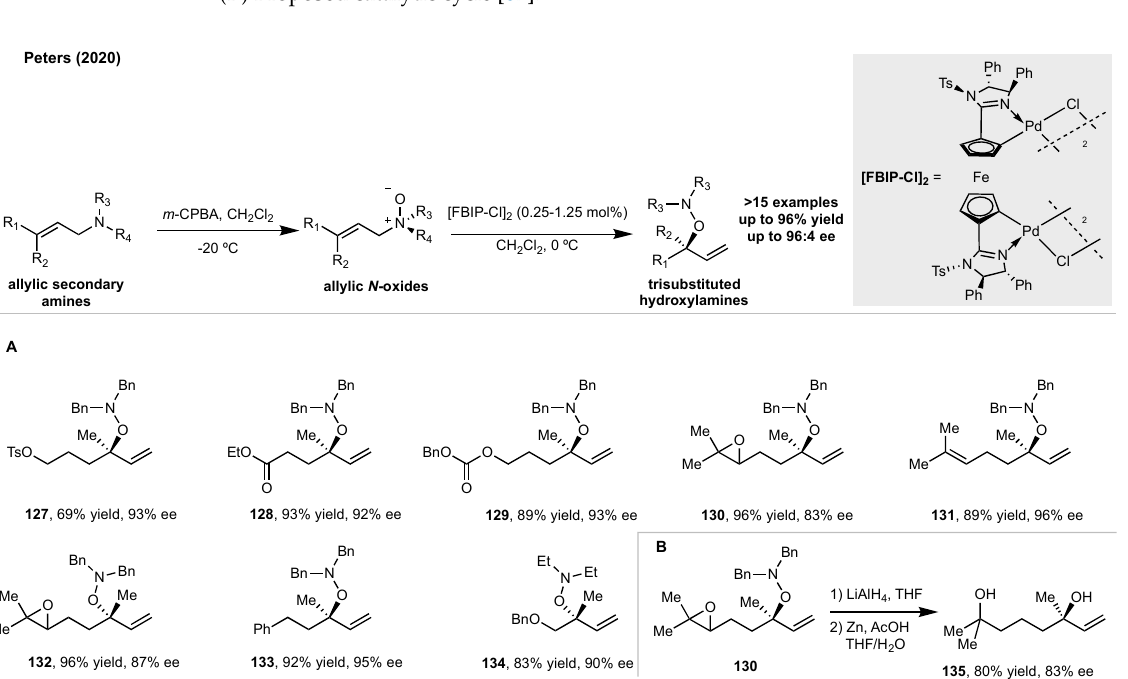
Scheme 13. Peters’ enantioselective [2,3]-sigmatropic rearrangement of allylic amine N -oxides for the synthesis of O - tert -alkyl trisubstituted hydroxylamines. ( A ) Selected examples of the transformation. ( B ) Elaboration of the products to complex tertiary alcohols [67,70].